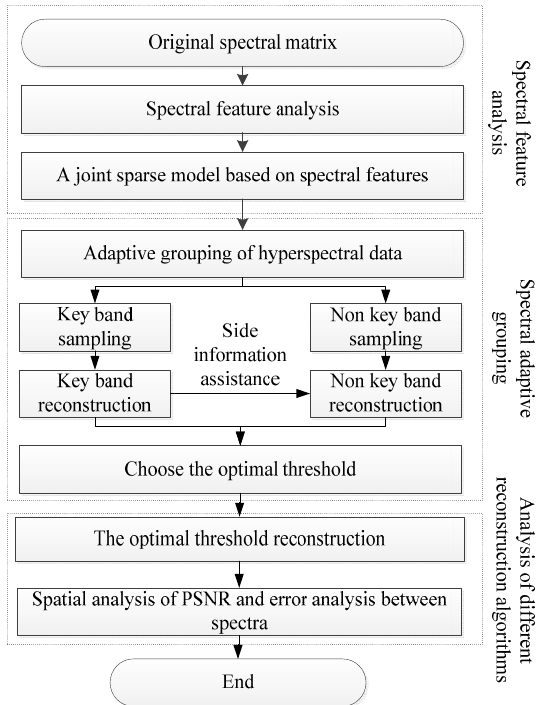
Figure 1. Flowchart of plant hyperspectral compressive sensing reconstruction.